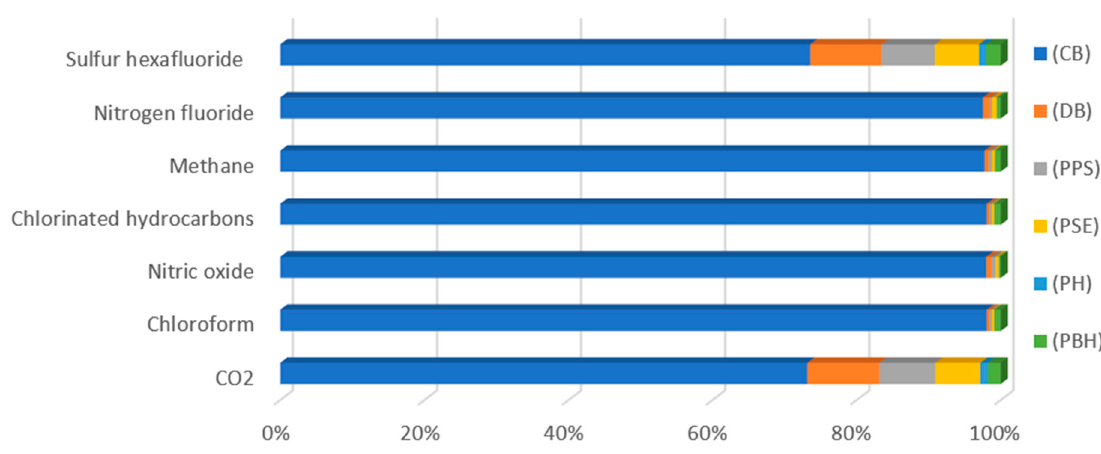
Figure 7. Results of characterization of environmental impacts for the category of global warming (DALY).